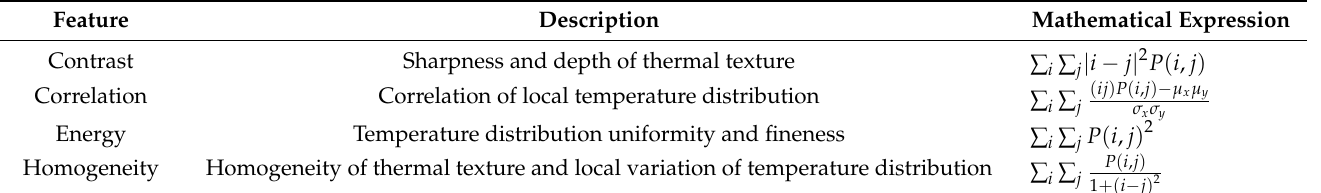
Table 3. Four second-order texture features calculated by